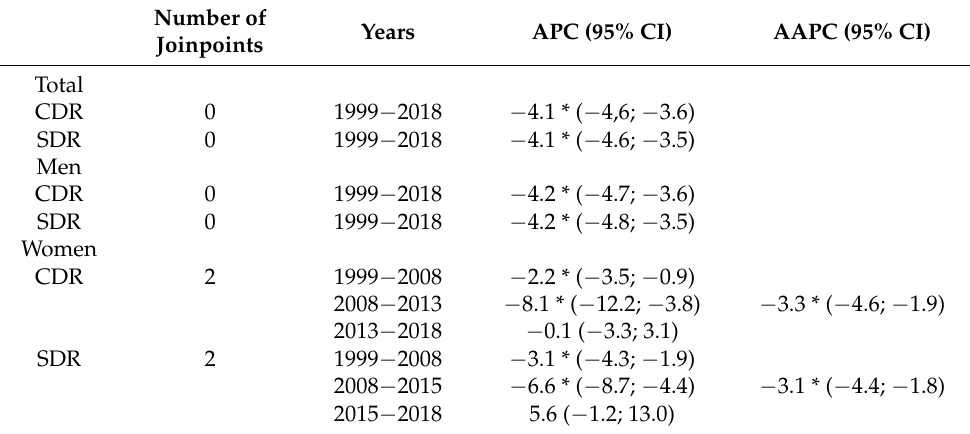
Table 2. Time trends of CDR and SDR due to road traffic injuries in Poland in 1999–2018—joinpoint regression analysis .